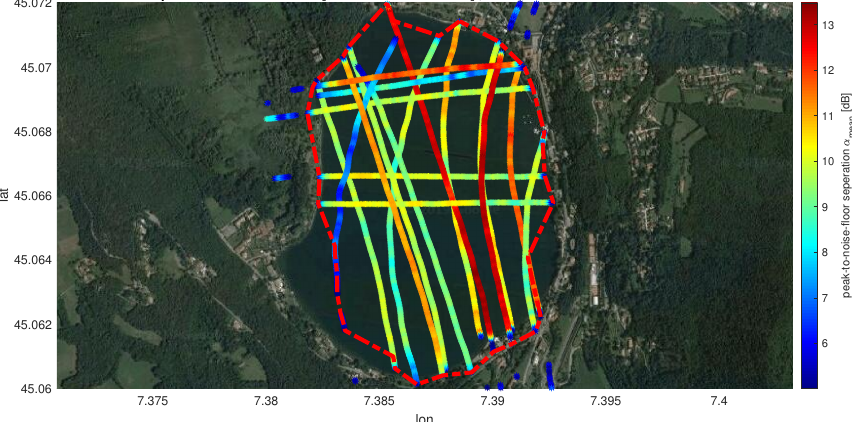
Figure 8. Estimation of the Northern Avigliana lake surface area using GNSS-R. The red dotted lines represent the estimated boundary of the lake from the GNSS signals reflected from the water